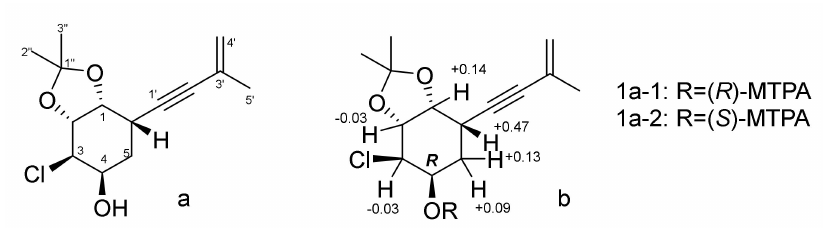
Figure 3. Chemical structure of 1a ( a ) and ∆ δ ( δ S - δ R ) values (in ppm) for MTPA esters of 1a ( b